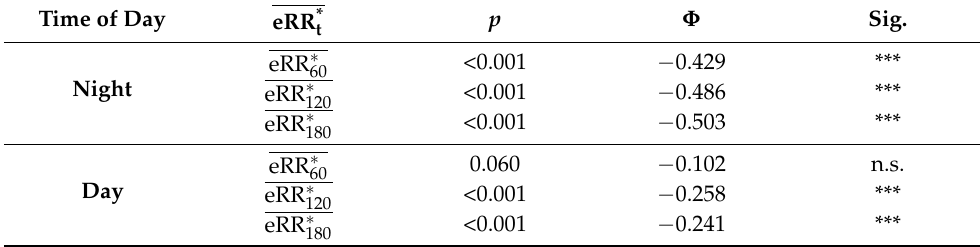
Table 5. X 2 -Tests investigating the influence of the daytime on the experimental retention rates with exclusion of the first hour of the trials and referring to the number of stocked fish. Experimental retention rates for one, two and three hours evaluation time (eRR ∗ , eRR ∗ and eRR ∗ ). Error 60 120 180 probability p , Φ and significance (n.s. denoting no significance, * p < 0.05, ** p < 0.01 and *** p < 0.001). p Φ Sig. Time of Day eRR * t eRR ∗ Night